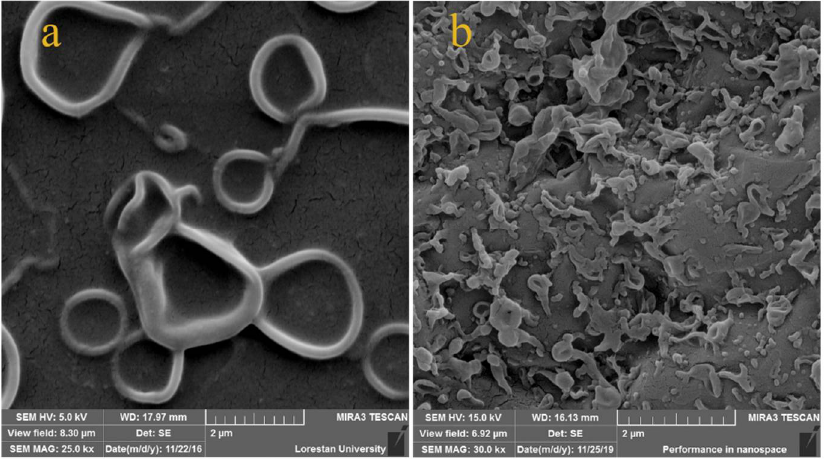
Figure 3. SEM micrographs of the surface of PA thin layer upon ( a ) conventional PES support and ( b ) PET-PNIPAAm